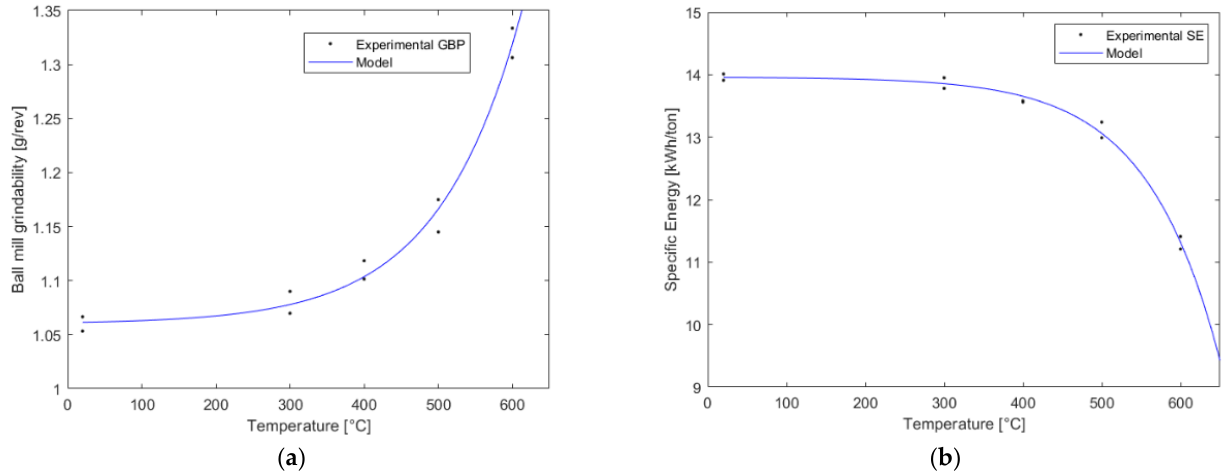
Figure 4. Grindability and specific energy as a function of the pre-treatment temperature: ( a ) ball mill grindability; ( b ) specific energy.